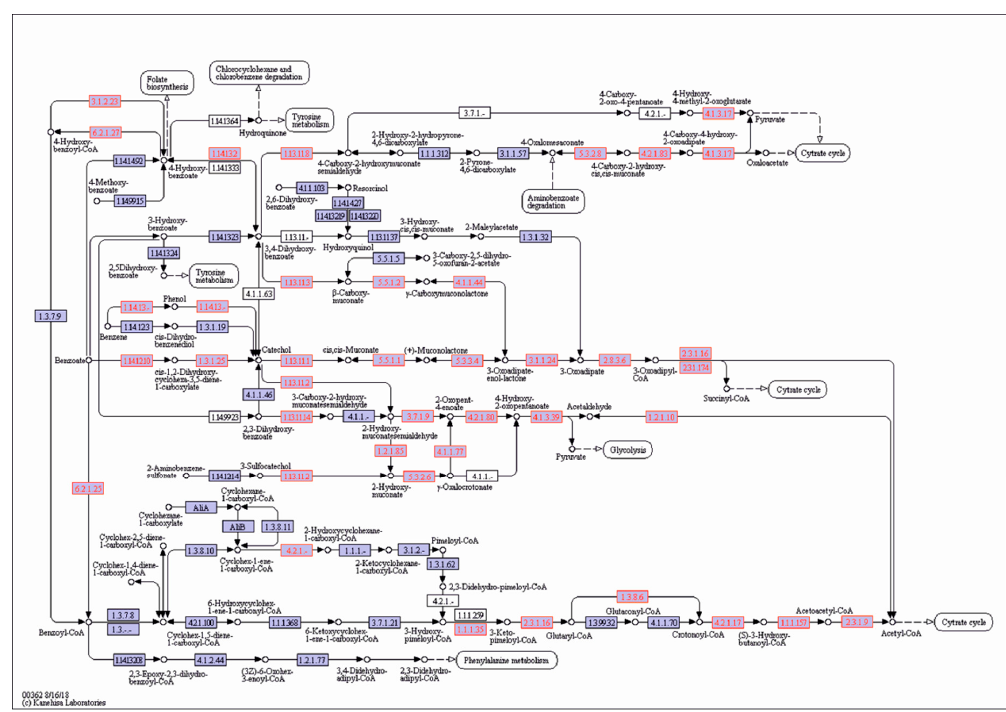
Figure 8. Locations of catabolic genes identified in P. putida KB3 (marked in pink) in the general microbial metabolic pathway for degradation of aromatic compounds.